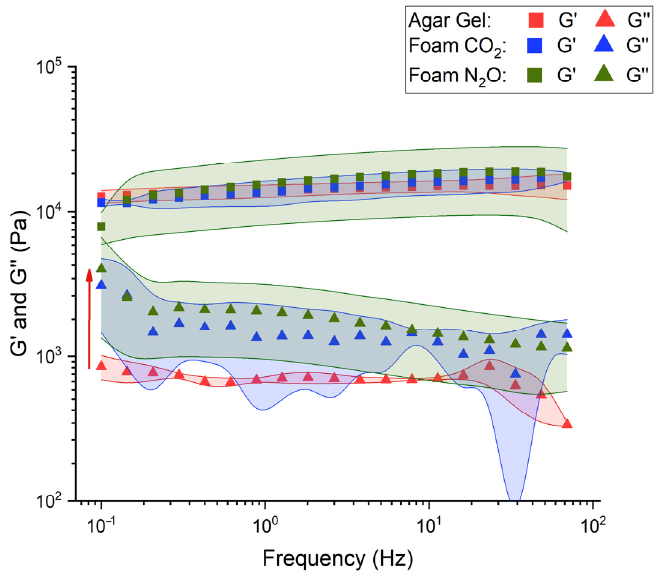
Figure 6. Figure 6. Viscoelastic modulus analyzed in frequency sweep test performed in the Linear Viscoe- lastic Region.